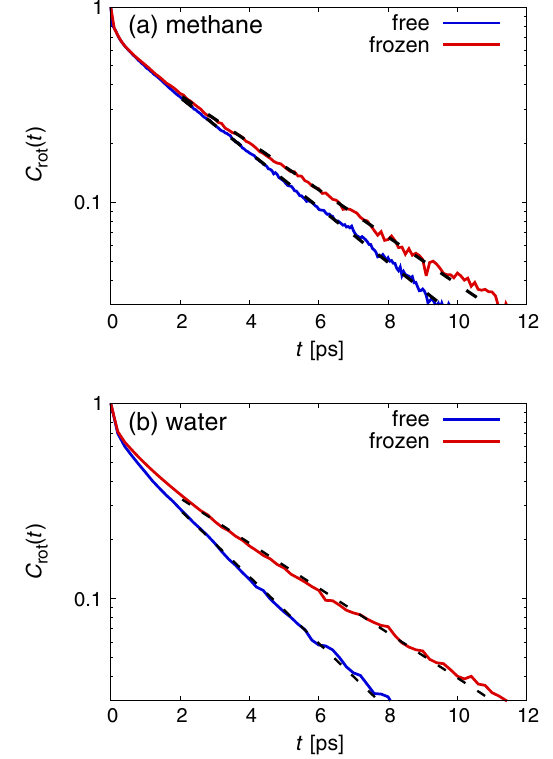
ð t Þ defined in rot